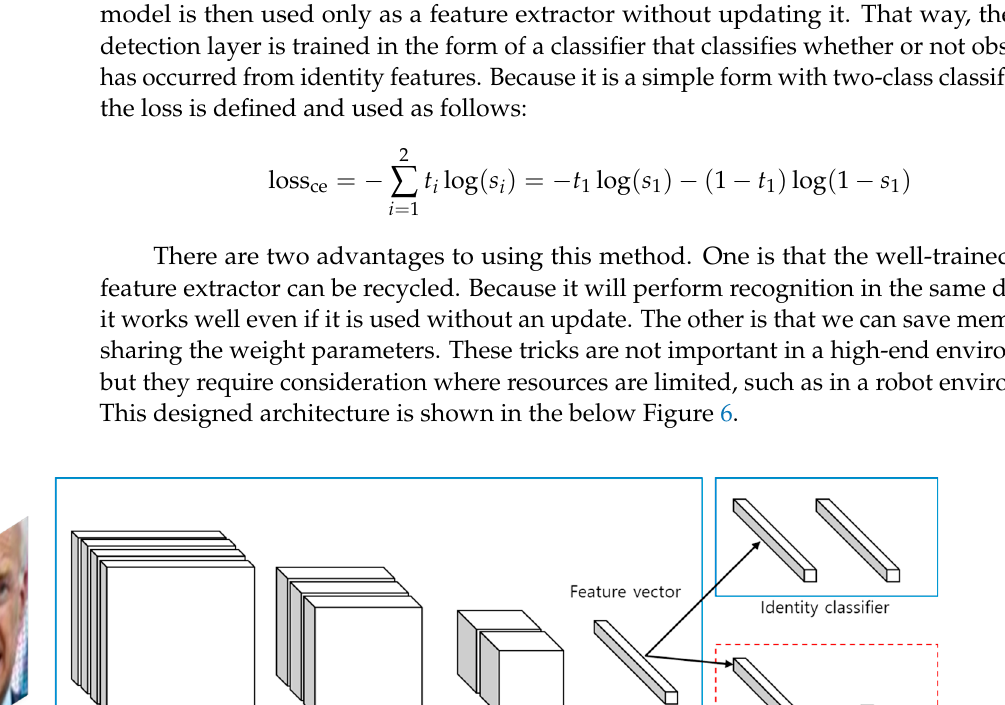
Figure 5. Example of the original image and the picture for occlusion detection.